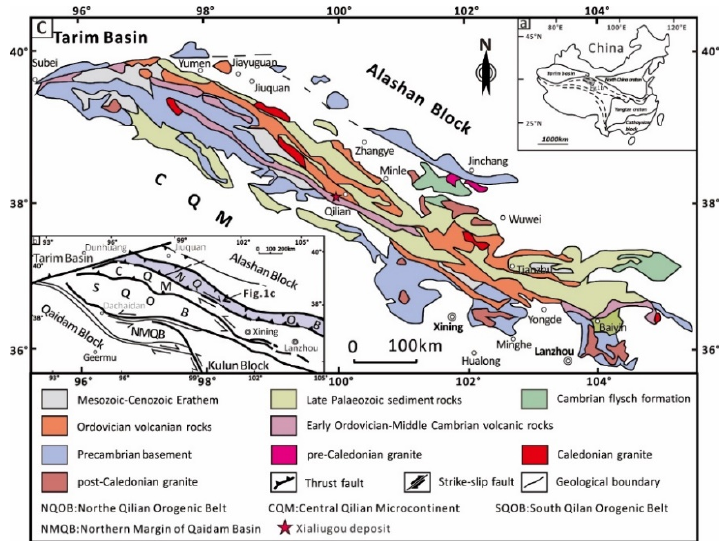
Figure 1. ( a ) Schematic map showing major tectonic units of China; ( b ) tectonic units of North Qilian Orogenic Belt (NQOB); ( c ) geological sketch map of the Northern Qilian, Mountains, modified from reference [7].